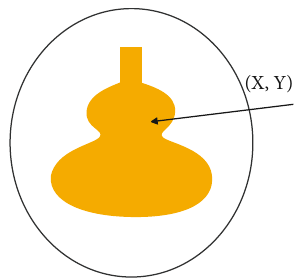
6: The force diagram of the monitoring image string in the ideological and political